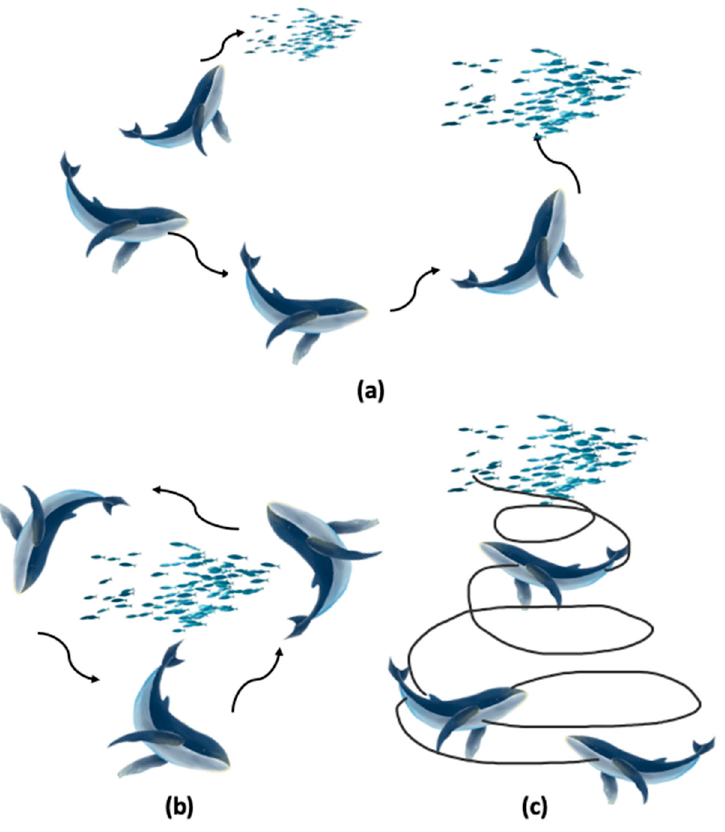
Figure 2. The process of humpback whales hunting prey: ( a ) the whales move toward the lead whale or in random directions; ( b ) whales reach their prey by the shrinking encircling mechanism; ( c ) whales reach their prey in a spiral shape.